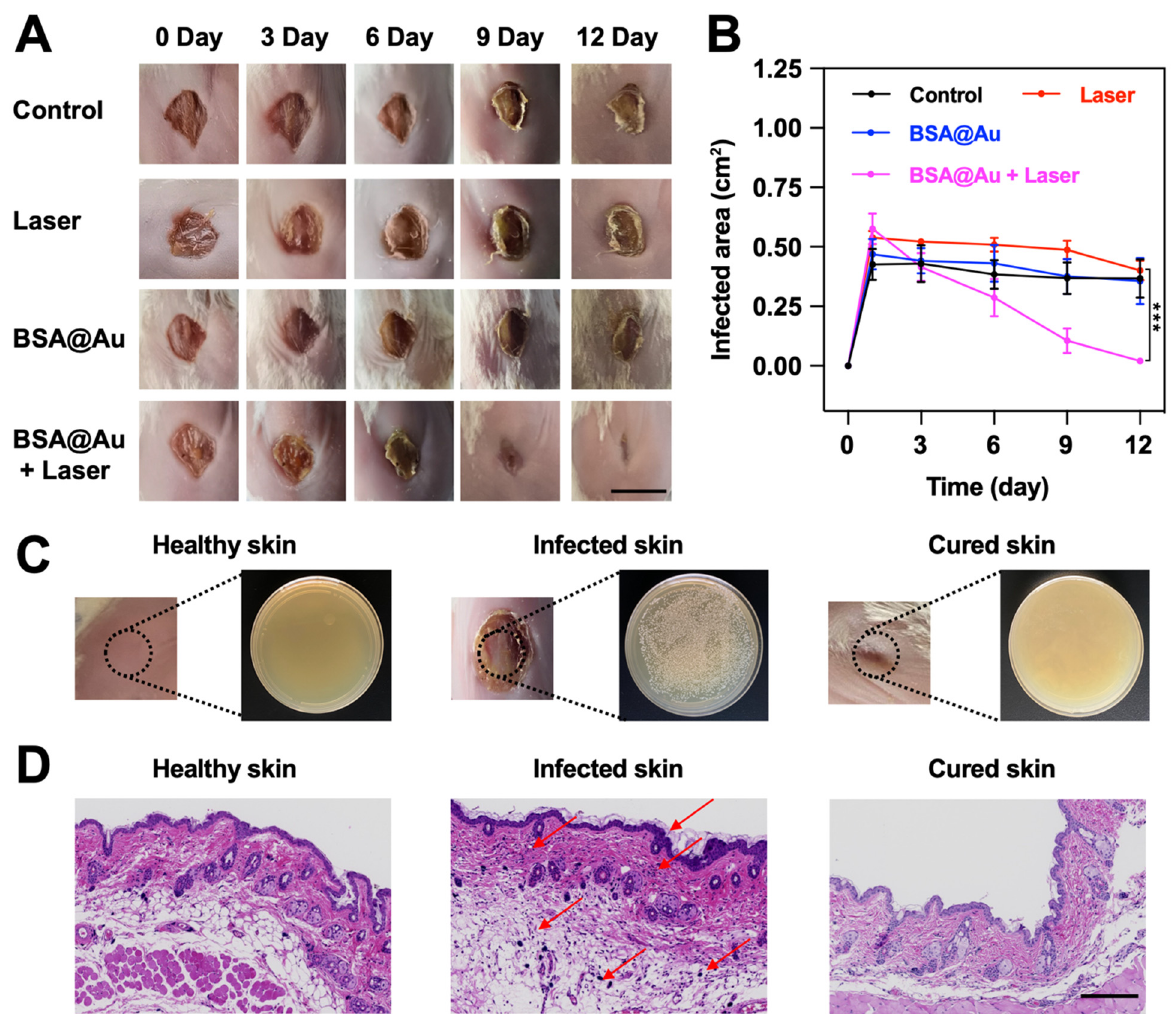
Figure 7. In vivo anti-bacterial effect. ( A ) Photographs of the infectious wounds after in vivo treatments. The scale bar was 1 cm. ( B ) Quantitative analysis of wound areas over time. ( C ) The MRSA colonies on LB-agar plates from the healthy skin tissue, the infected skin tissue, and the cured skin tissue, respectively. ( D ) H&E staining analysis of wounds from the healthy skin tissue, the infected skin tissue, and the cured skin tissue, respectively. The scale bar was 200 µm, and the red arrows represented tissue inflammation. *** p < 0.005.